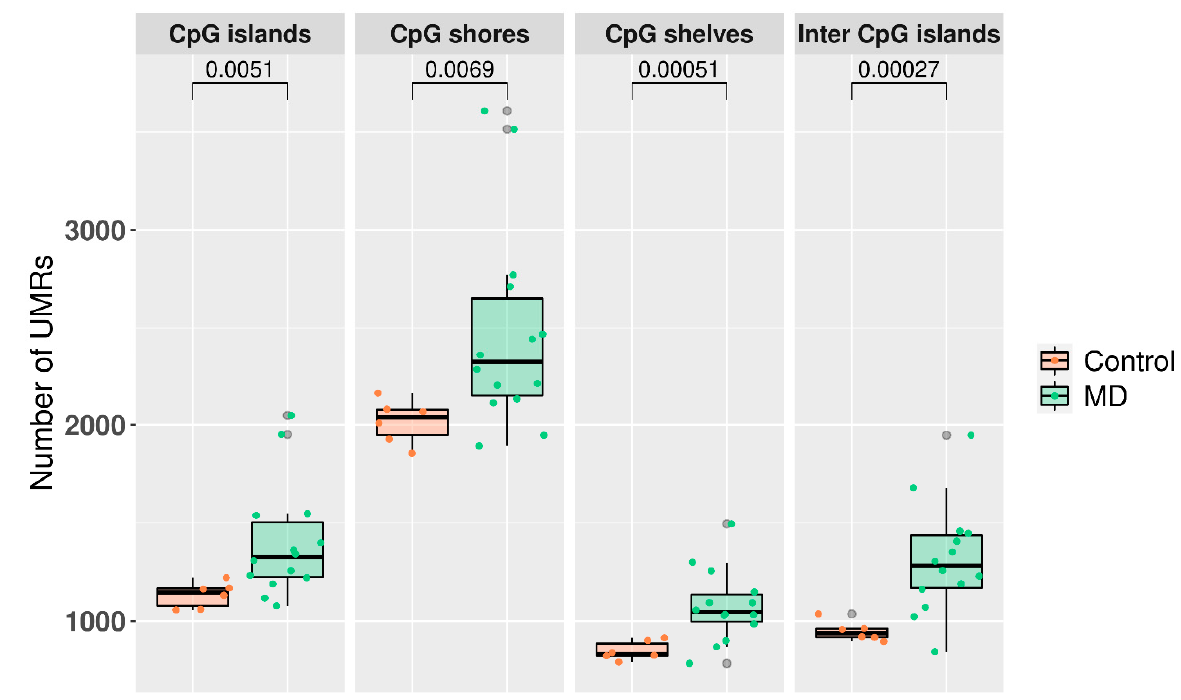
Figure 3. Boxplot representing the genomic region distribution of undermethylated regions (UMR) in MD and controls. Student’s t -test was used to calculate the p -value in each comparison.